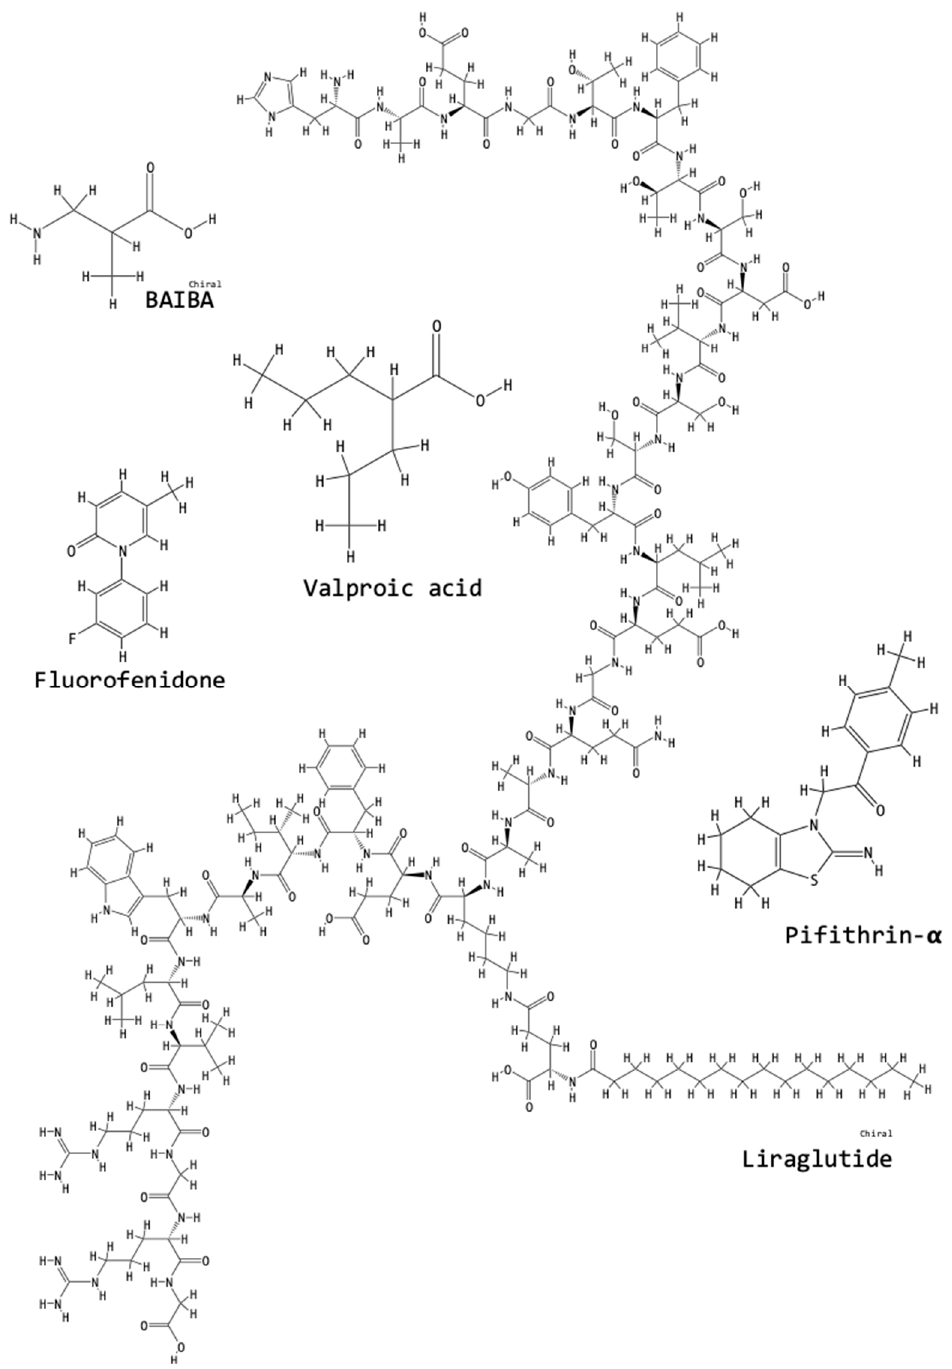
Figure 6. Chemical structures of purified or synthesized compounds and a selected recombinant protein tested for fibrosis-ameliorating activity in the context of the UUO model. The structures were obtained from the PubChem database [60]: the “PubChem CID” for each compound has been listed in the text next to the compound’s name.